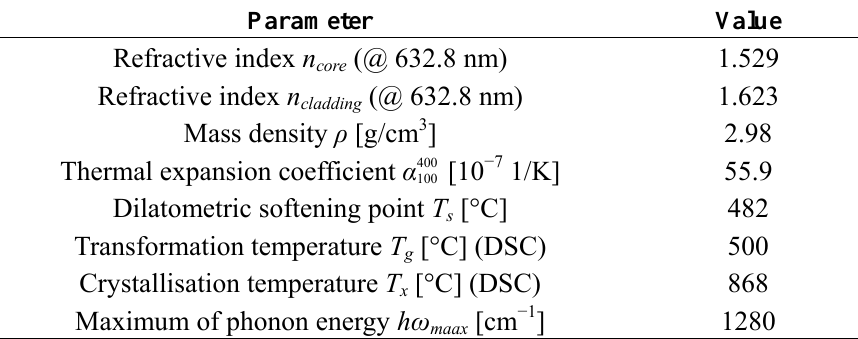
Table 1. Material and thermal parameters of fabricated